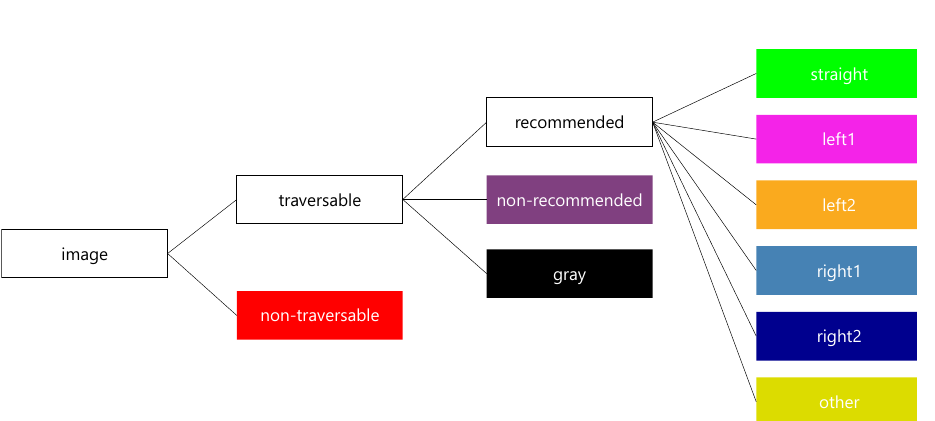
Figure 9. Classes and colors for labeling. The label “straight” means the area indicating the direction to go along the road, “left1” (“right1”) means an area indicating left or right turn direction before crossing the road, “left2” (“right2”) means an area indicating left or right turn direction after crossing the road, and “other” means an area that does not determine the direction but is recommended.